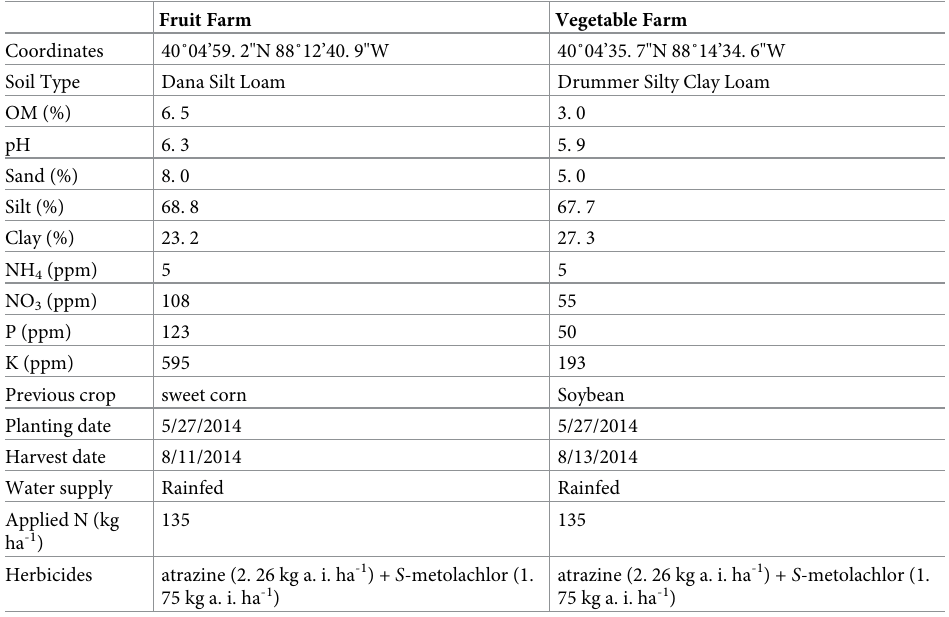
Table 1. Description of sites used for plant density experiment near Urbana,